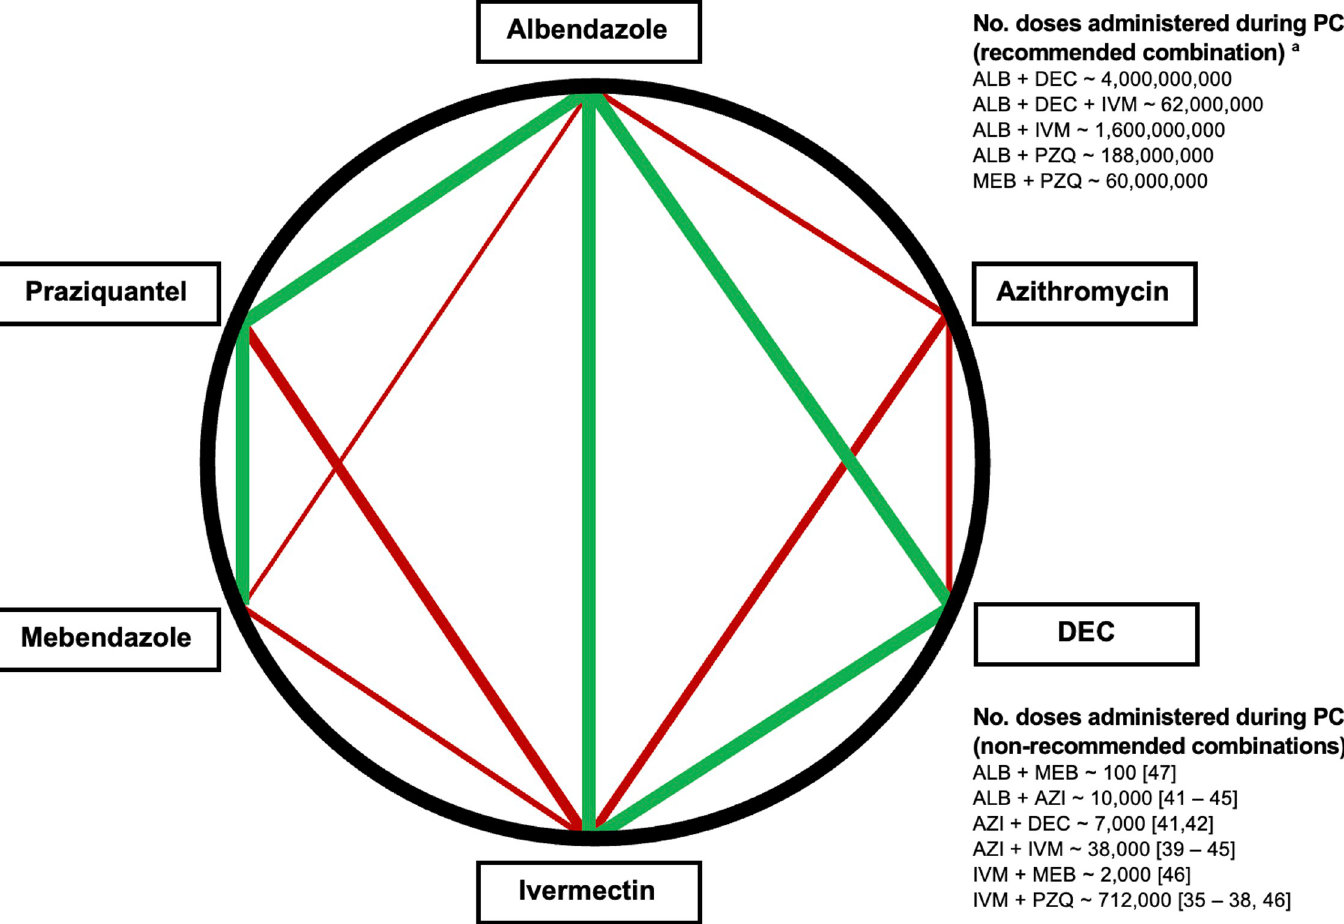
Fig 1. NTD drug coadministration safety Evidence strength. Green lines represent WHO-recommended combinations. Red lines represent non-WHO-recommended combinations. Thicker lines represent more available safety data. (a) Personal communication, Drs. Jonathan King and Denise Mupfasoni, WHO; data from 2010–2020. ALB, albendazole; AZI, azithromycin; DEC, diethylcarbamazine; IVM, ivermectin; MEB, mebendazole; PZQ,